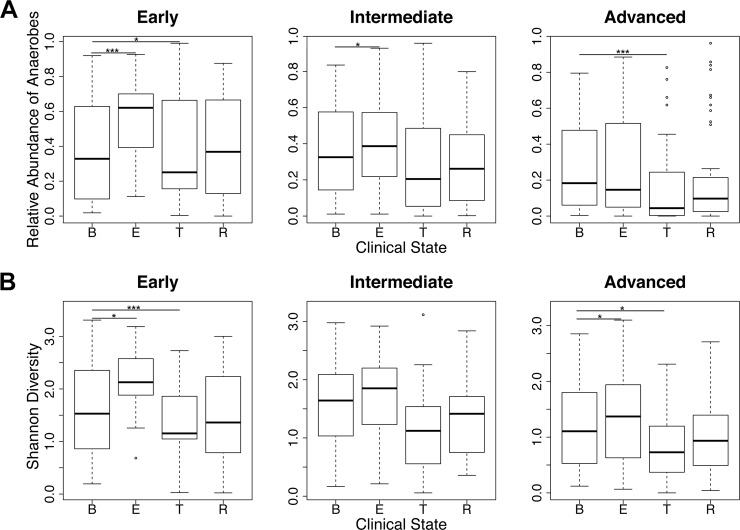
Changes in community structure across clinical states differ based on patient disease stage.(A) Cumulative relative abundance of anaerobic genera (Actinomyces, Fusobacterium, Gemella, Granulicatella, Porphyromonas, Prevotella, Rothia, Streptococcus and Veillonella spp) and (B) Shannon diversity by subject clinical state, at early, intermediate, and advanced lung disease stages.* P ≤ 0.05 (GEE), ***P ≤ 0.001 (GEE).